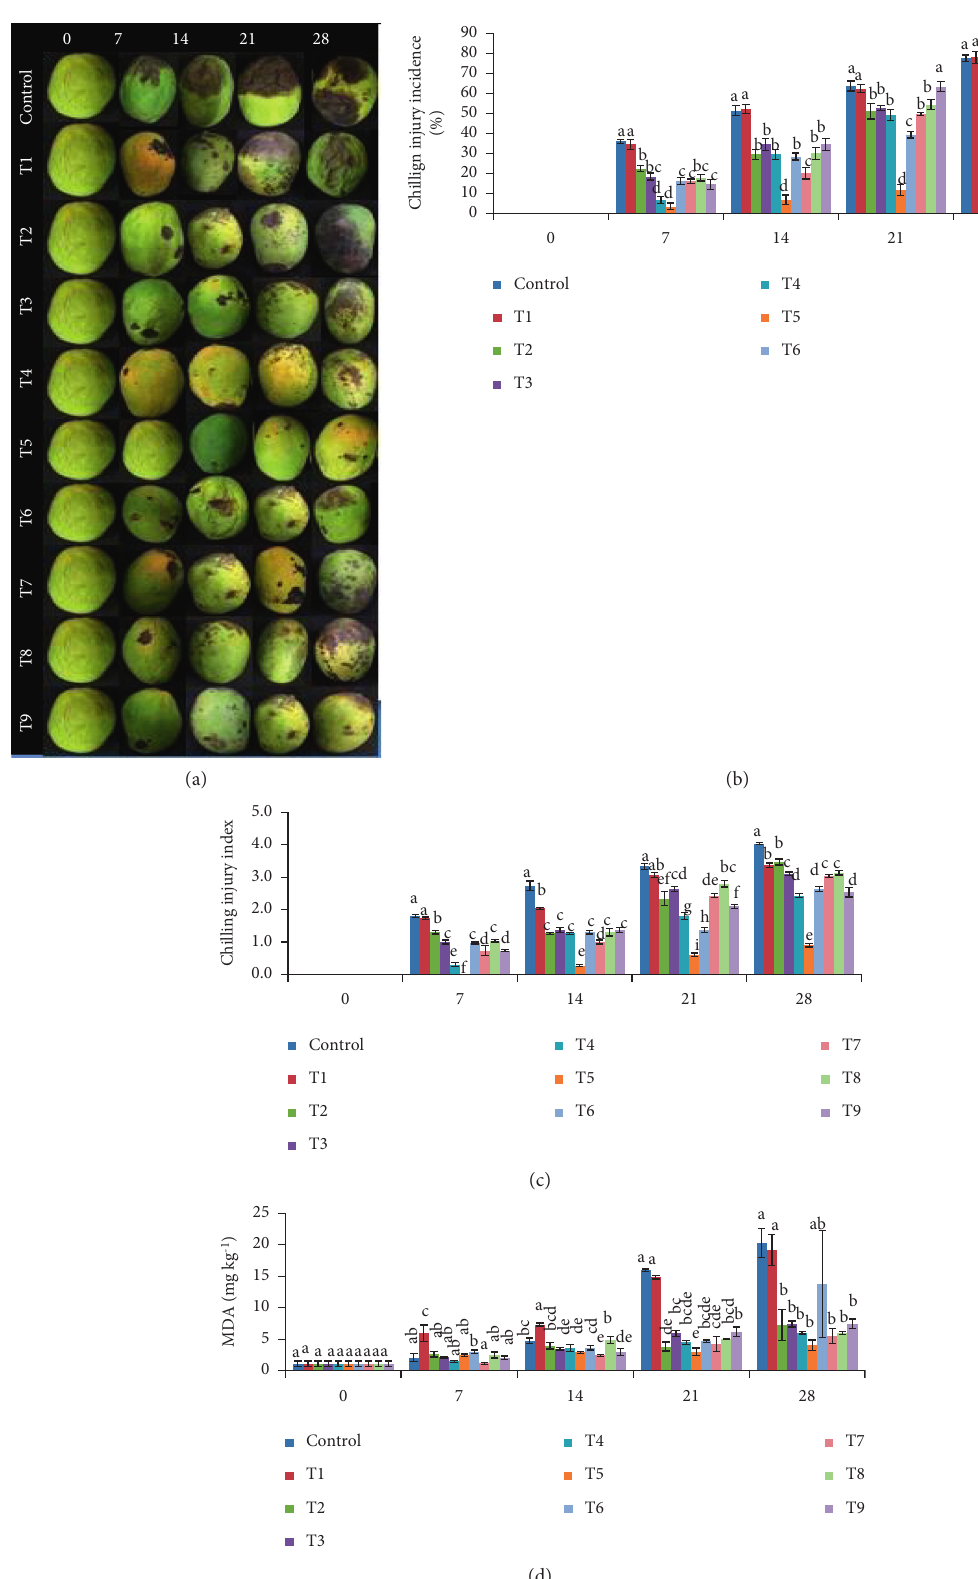
Figure 1: (a) Representative images, (b) chilling injury (CI) incidence, (c) CI index, and (d) malondialdehyde (MDA) of mango cv. “Dashehari” treated with melatonin (MT), followed by low-temperature storage at 5 ± 1 ° C. Measurements were taken every 7 d of storage, followed by a 3d of shelf life at room temperature. Each value is the mean of three replicates; vertical bars indicate the standard error. Different lowercase letters on the same storage period indicate a significant difference ( p < 0 . 05) according to Duncan’s multiple range test. The abbreviated treatment details: 0 (control), 50 µ M for 90min (T1), 50 µ M for 120min (T2), 50 µ M for 150min (T3), 100 µ M for 90min (T4), 100 µ M for 120min (T5), 100 µ M for 150min (T6), 150 µ M for 90min (T7), 150 µ M for 120min (T8), and 150 µ M for 150min